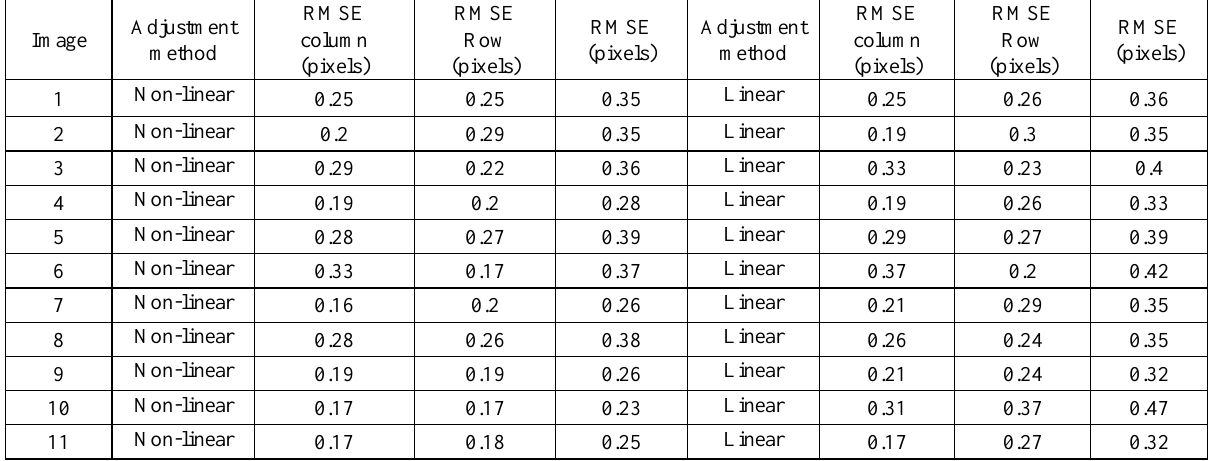
Table 2. Accuracy of each scene image